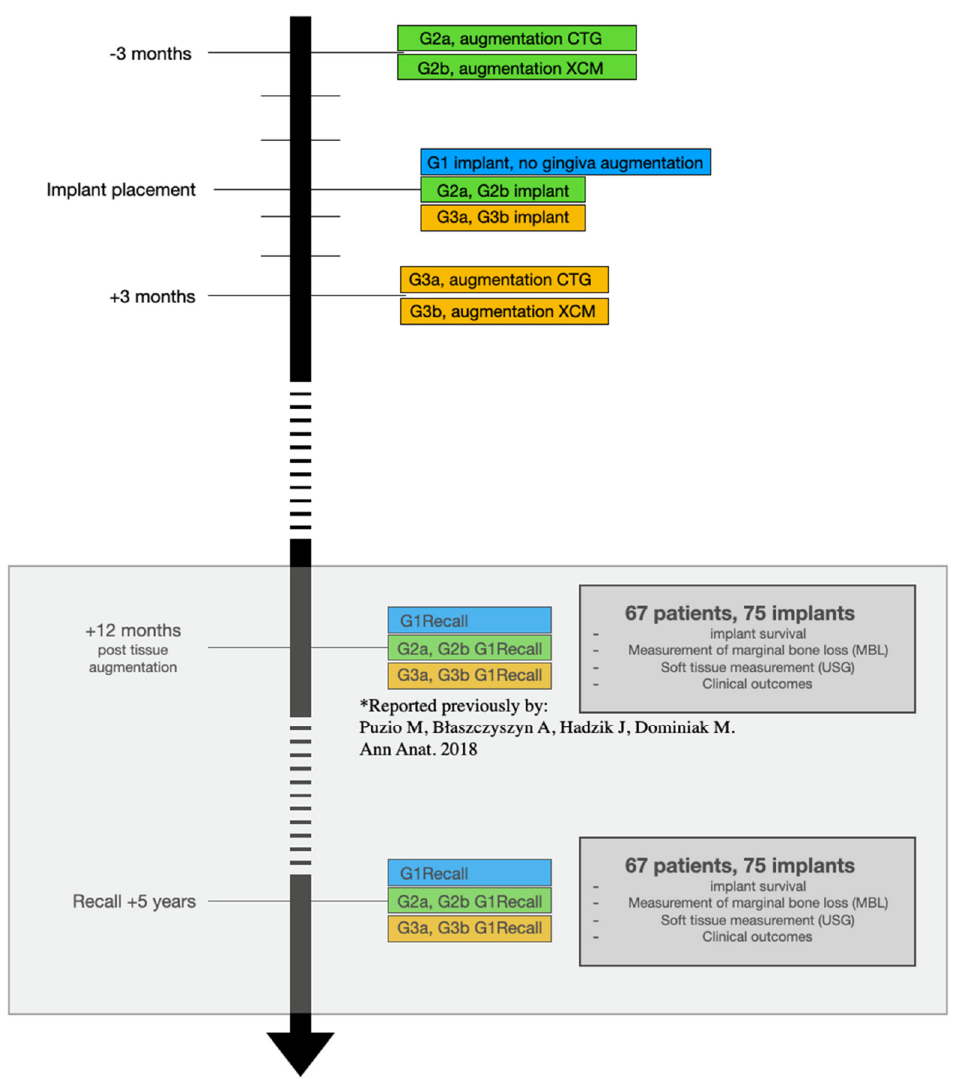
Figure 2. Study timeline, primary and secondary study endpoints [7].